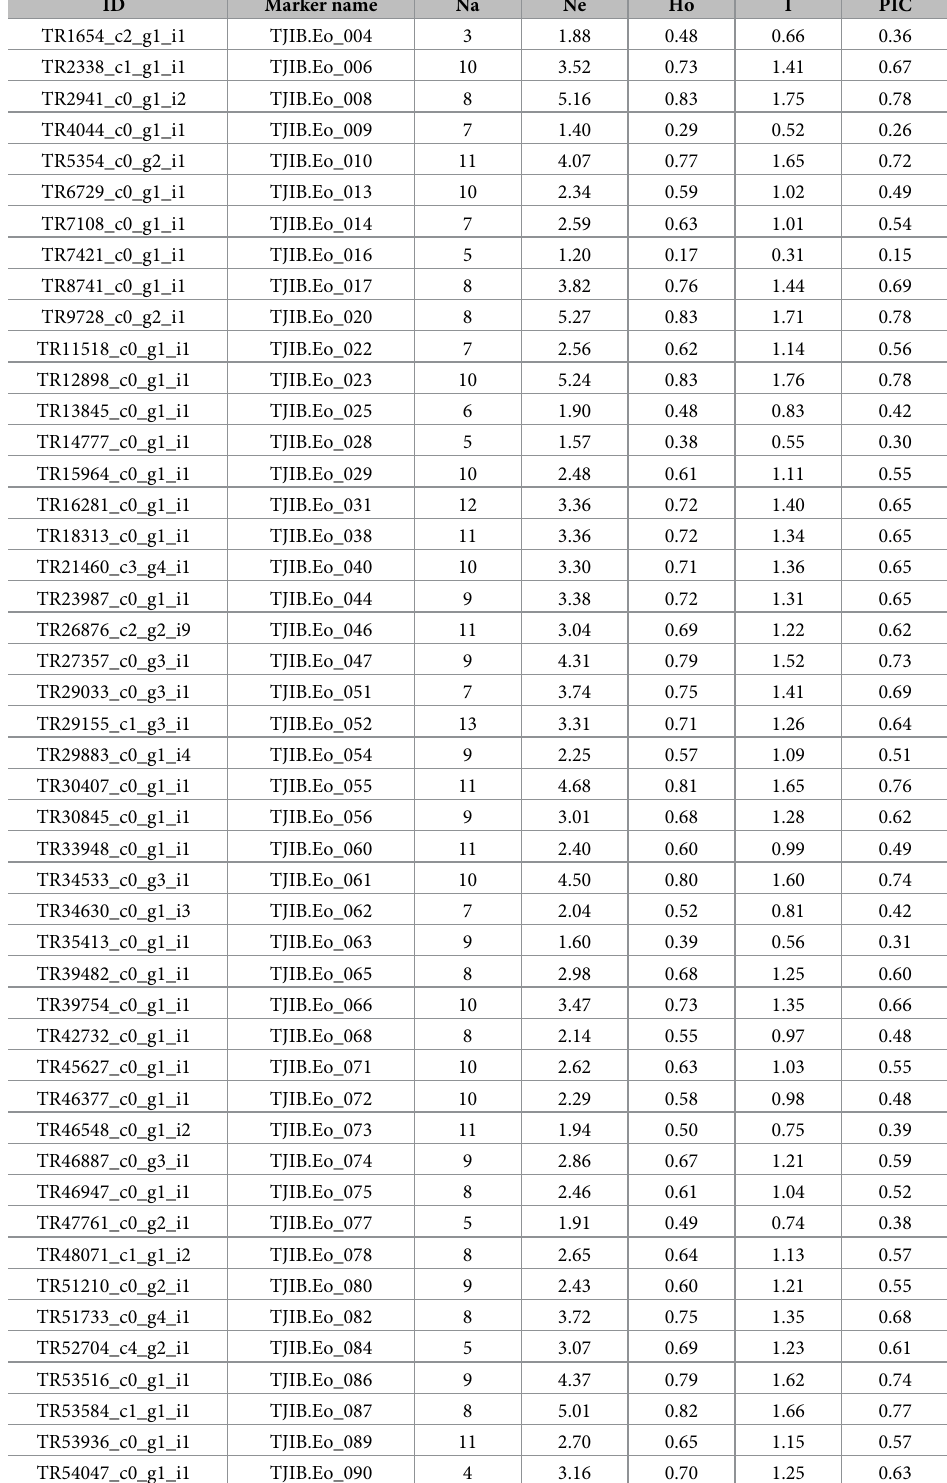
Table 4. Polymorphism statistics of novel SSR markers in 43 E . ophiuroides core